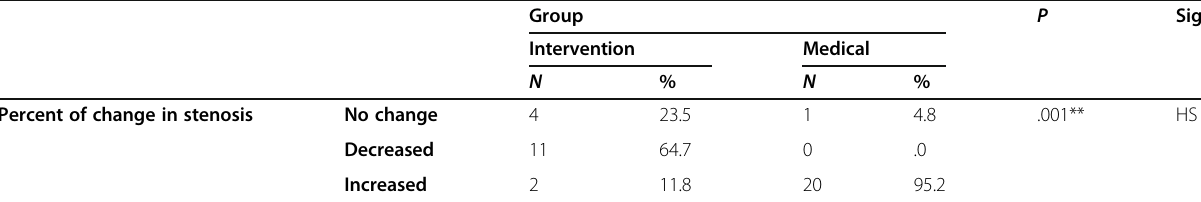
Table 9 Change of percent of stenosis